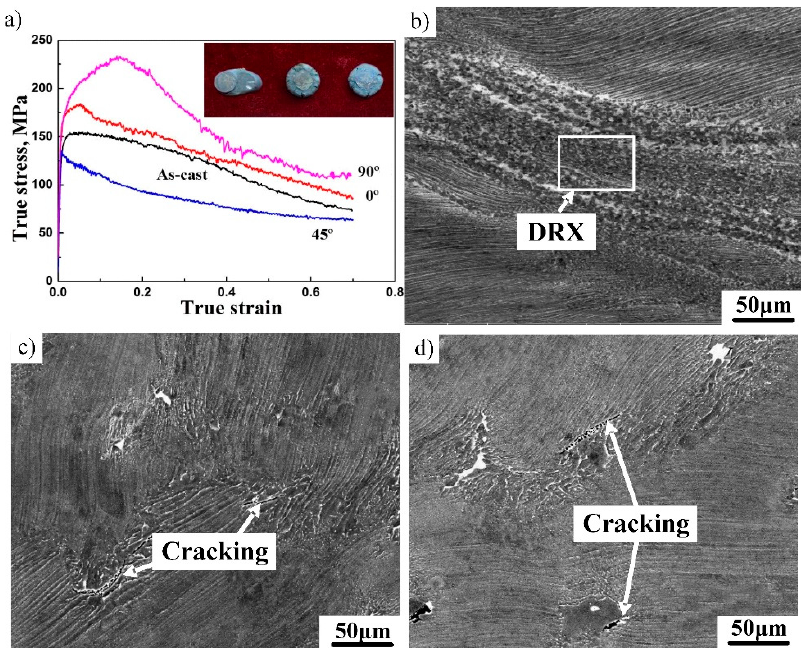
Figure 4. The effect of lamellar orientation on the deformation resistance and microstructural Figure 4. The e ff ect of lamellar orientation on the deformation resistance and microstructural evolution evolution of Ti–43Al–2Cr–2Mn–0.2Y alloy. ( a ) True stress–true strain curves, ( b ) 45°, ( c ) 0°, ( d ) 90°. of Ti–43Al–2Cr–2Mn–0.2Y alloy. ( a ) True stress–true strain curves, ( b ) 45 ◦ , ( c ) 0 ◦ , ( d ) 90 ◦